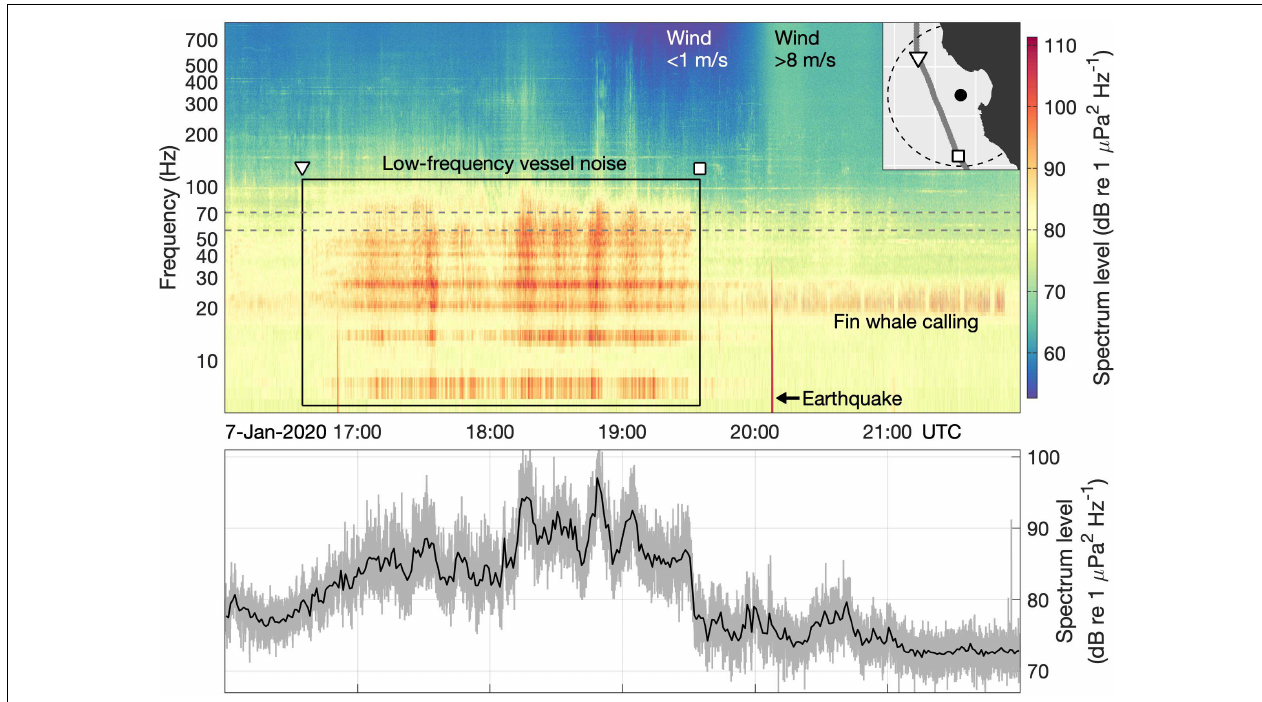
FIGURE 4 | Low-frequency vessel noise within the greater soundscape at MARS. Spectrogram calculation used 2 kHz data (decimated from 256 kHz), 2,000 pt. FFT, Hanning window, no overlap. The box bounds temporal and frequency limits of the strongest signal from a southbound transit of the container vessel MSC SILVANA (IMO: 9309459; length overall 332 m). A portion of the vessel track is shown in the inset map, with time markers corresponding to those in the spectrogram (triangle, square); vessel speed was steady at 21.4 ± 0.16 knots during this portion of the transit. The black dashed line in the inset map defines an 80 km radius from MARS for scale reference. Other identifiable sounds include biological (fin whale calling) and geophysical (wind, earthquake). The fin whale calls are series of ∼ 1 s pulses with peak energy near 20 Hz. The increase in spectrum levels above ∼ 150 Hz beginning near hour 20 followed a rapid increase in wind speeds from < 1 m/s to > 8 m/s (measured at NDBC Station 46042, located 20.6 km NW of MARS). The dashed gray lines define the frequency band used to quantify shipping noise from the recording time series, the one-third octave band centered at 63 Hz. The lower panel represents spectrum levels for this focal frequency band at 1-s resolution (gray) and 1-min L50